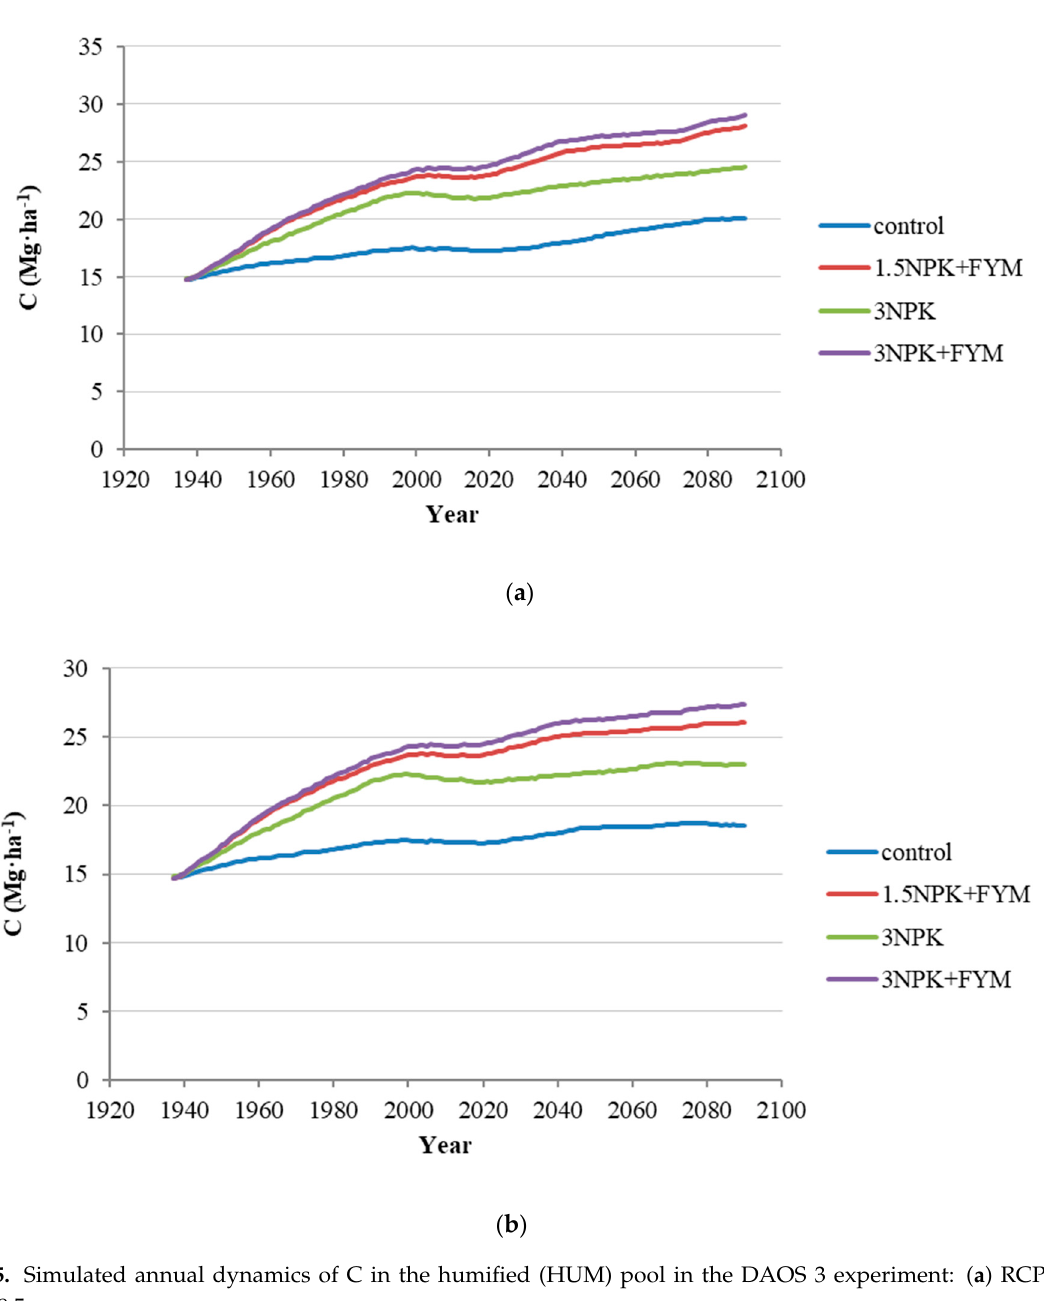
Figure 5. Simulated annual dynamics of C in the humified (HUM) pool in the DAOS 3 experiment: ( a ) RCP4.5 and ( b ) RCP8.5.